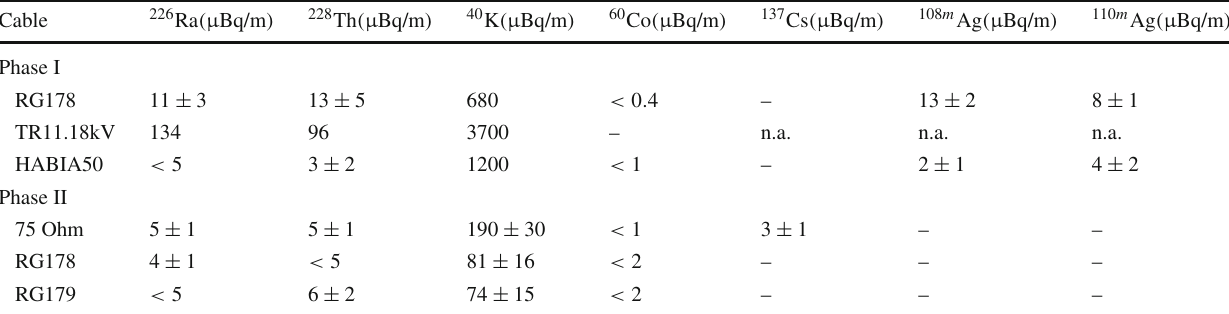
Phase I readout/HV ‘cable’, a high-purity copper wire within a PTFE tube, refer to its